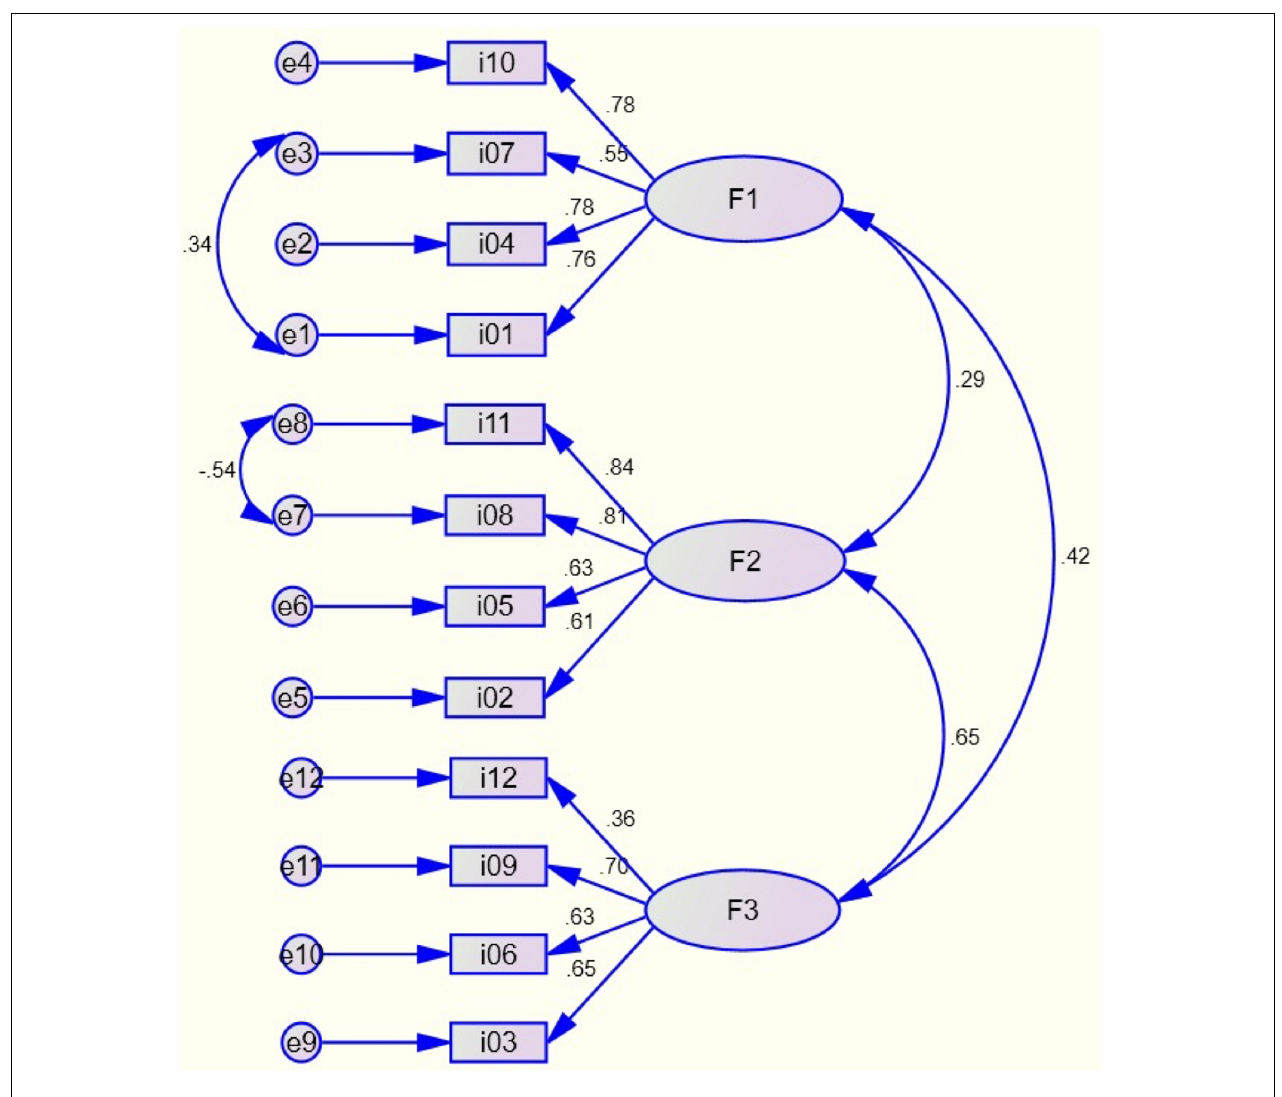
FIGURE 3 | Path analysis diagram. TABLE 2 | Discriminant and convergent